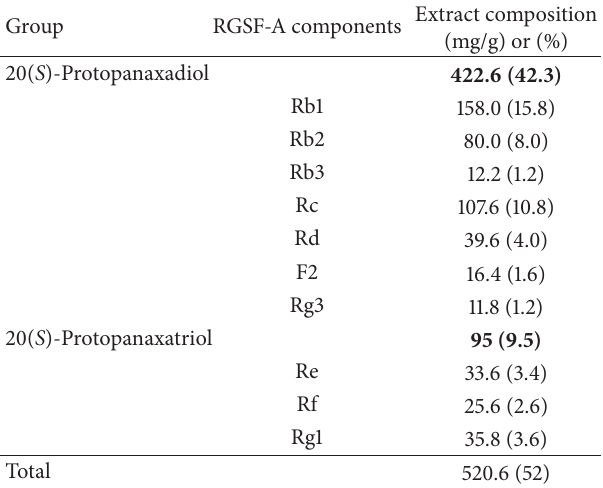
Extract composition (mg/g) or (%)